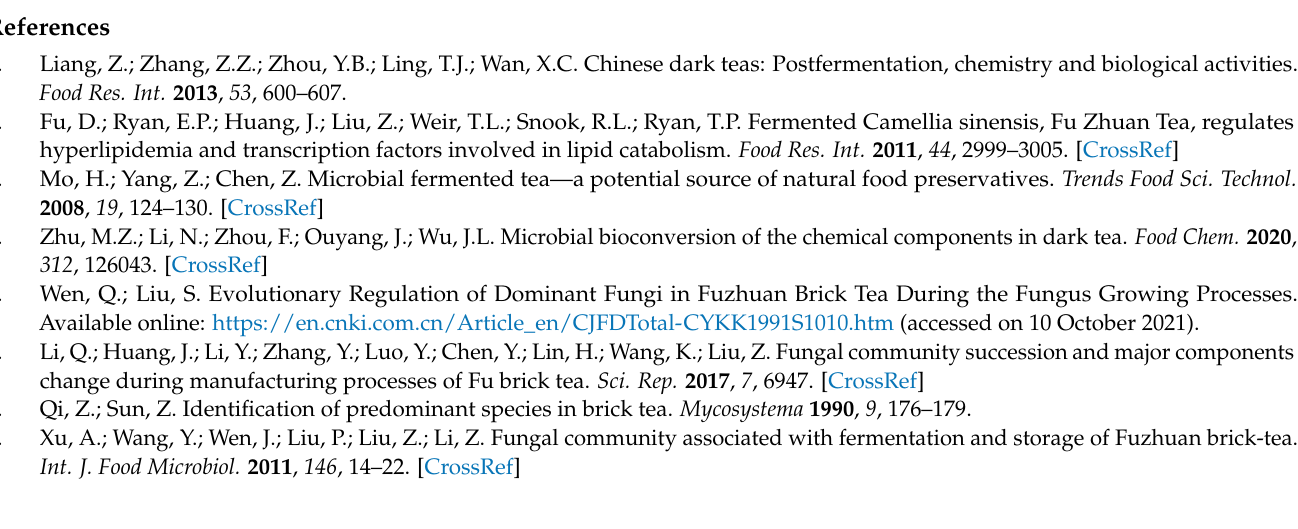
Figure S4: The number of operational taxonomic units (OTUs) and alpha diversity estimators for bacterial communities in the FBT samples, Table S1: Diversity analysis of fungal communities in the FBT samples, Table S2: Diversity analysis of bacterial communities in the FBT samples, Table S3: Total of 178 metabolites identified in FBT samples, Table S4: HPLC detection of 19 amino acids in the FBT samples (mg/g), Table S5. VIF value of nine critical